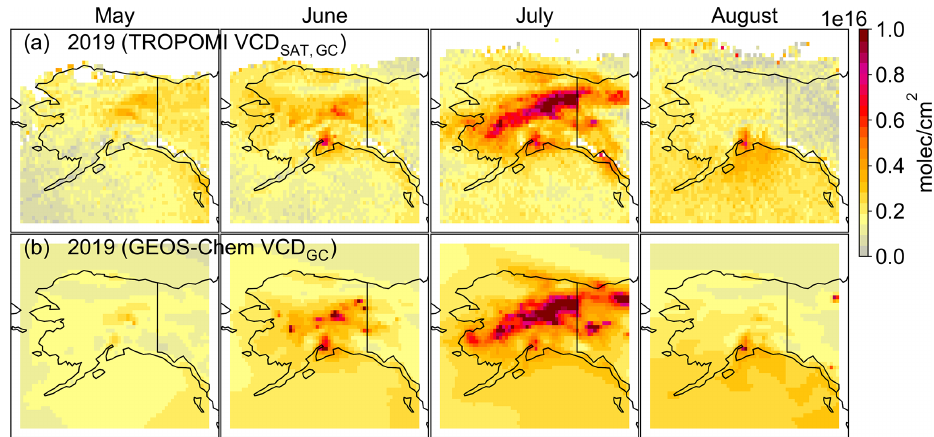
Figure 4. Reprocessed TROPOMI HCHO VCD SAT , GC (a) and GEOS-Chem HCHO VCD GC (b) in 2019 summer. The TROPOMI opera-